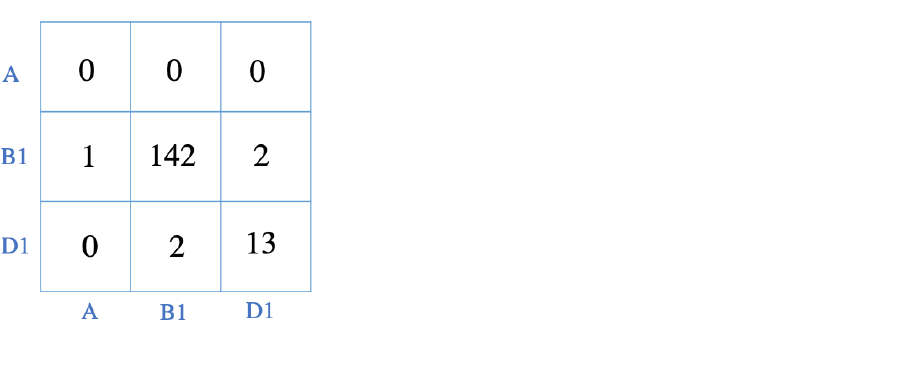
Figure 11. The confusion matrix comparing the forecasting postures with the actual postures. The classes are consistent with the definition of labels presented in Section